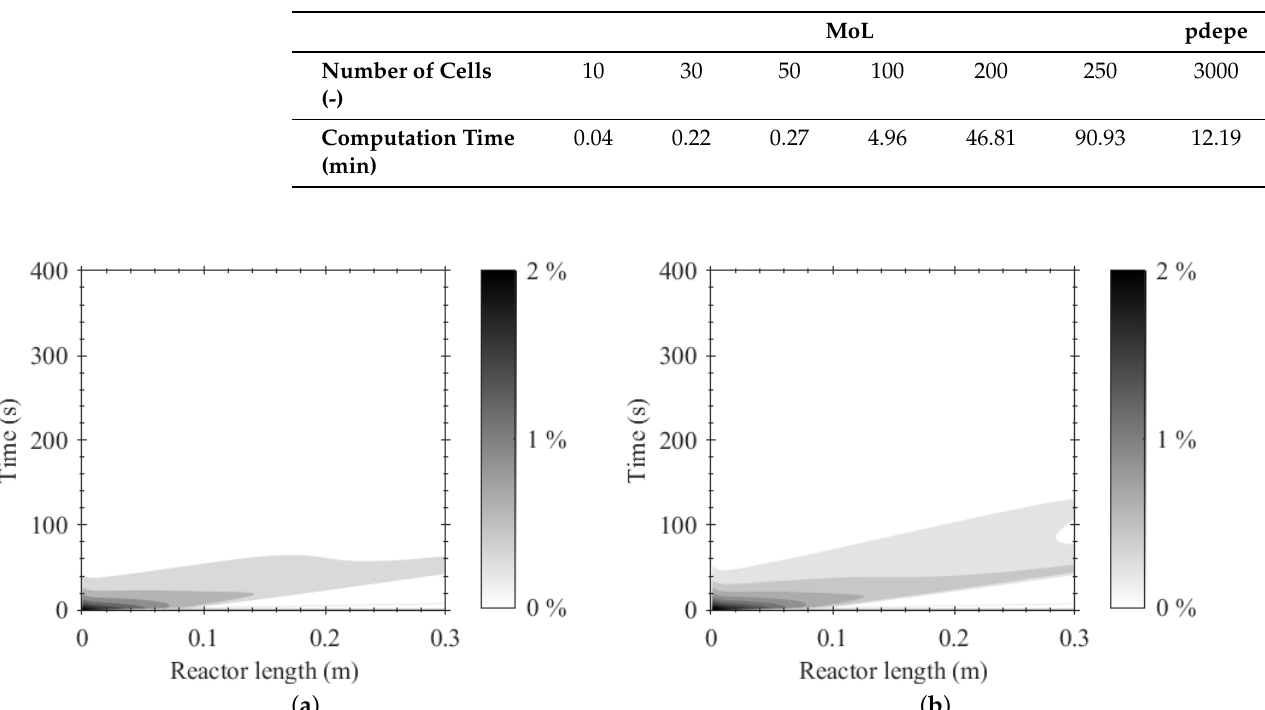
Table A2. Computation time for pdepe and MoL simulations for reactive adsorption in one reac- tion chamber.